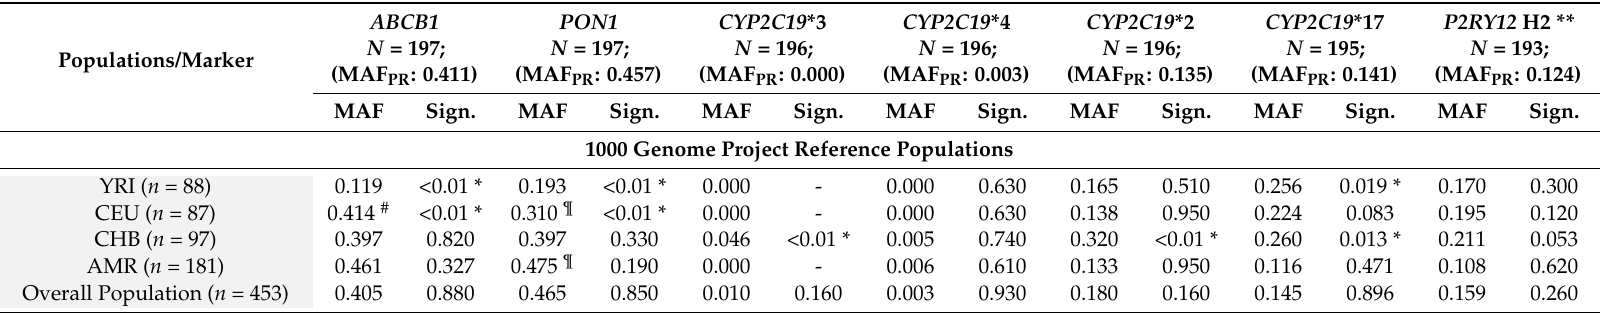
Table 2. Comparisons of minor allele frequencies (MAFs) between the study cohort and all the parental/reference populations of the 1000 Genome Project/Phase 3. The corresponding p -values are depicted in the column named “Sign.”, where an asterisk is added to indicate statistical significance ( p < 0.05). MAF PR stands for observed minor allele frequency in Puerto Ricans from the study